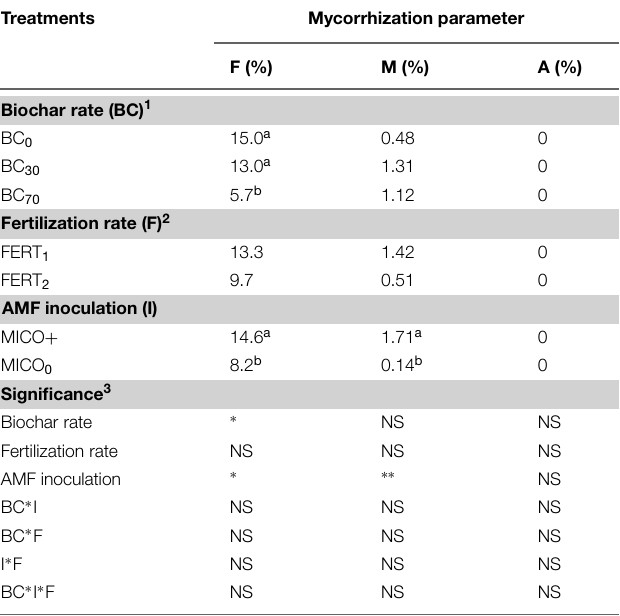
TABLE 3 | Mycorriza colonization frequency (F) and intensity (M), and arbuscule abundance (A) of Pelargonium plants inoculated (MICO + ) or not (MICO 0 ) with arbuscular mycorrhizal fungi (AMF) and grown for 74 d in substrate amended with different rates of biochar (BC 0 , BC 30 , BC 70 ), and fertilized with different rates of fertilizer (FERT 1 , FERT 2